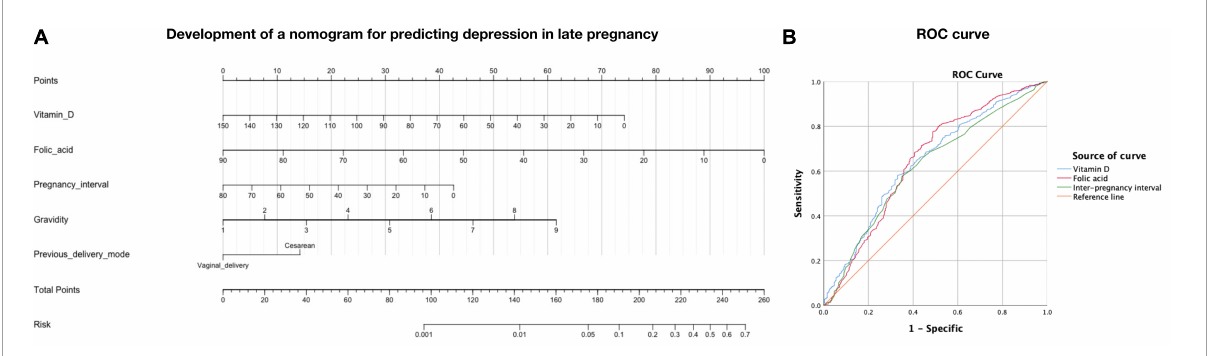
FIGURE2 (A) A nomogram model to predict the incidence rate of third-trimester depression. To calculate the probability of depression in the third trimester, draw a vertical line on the corresponding axis of each risk factor until it reaches the top line marked “point,” summarize the points of all risk factors, and then draw a line down the axis marked “total points” until it intersects the lower line indicating the probability of depression. (B) ROC curves of relationships between the risk factors and the occurrence of depression.